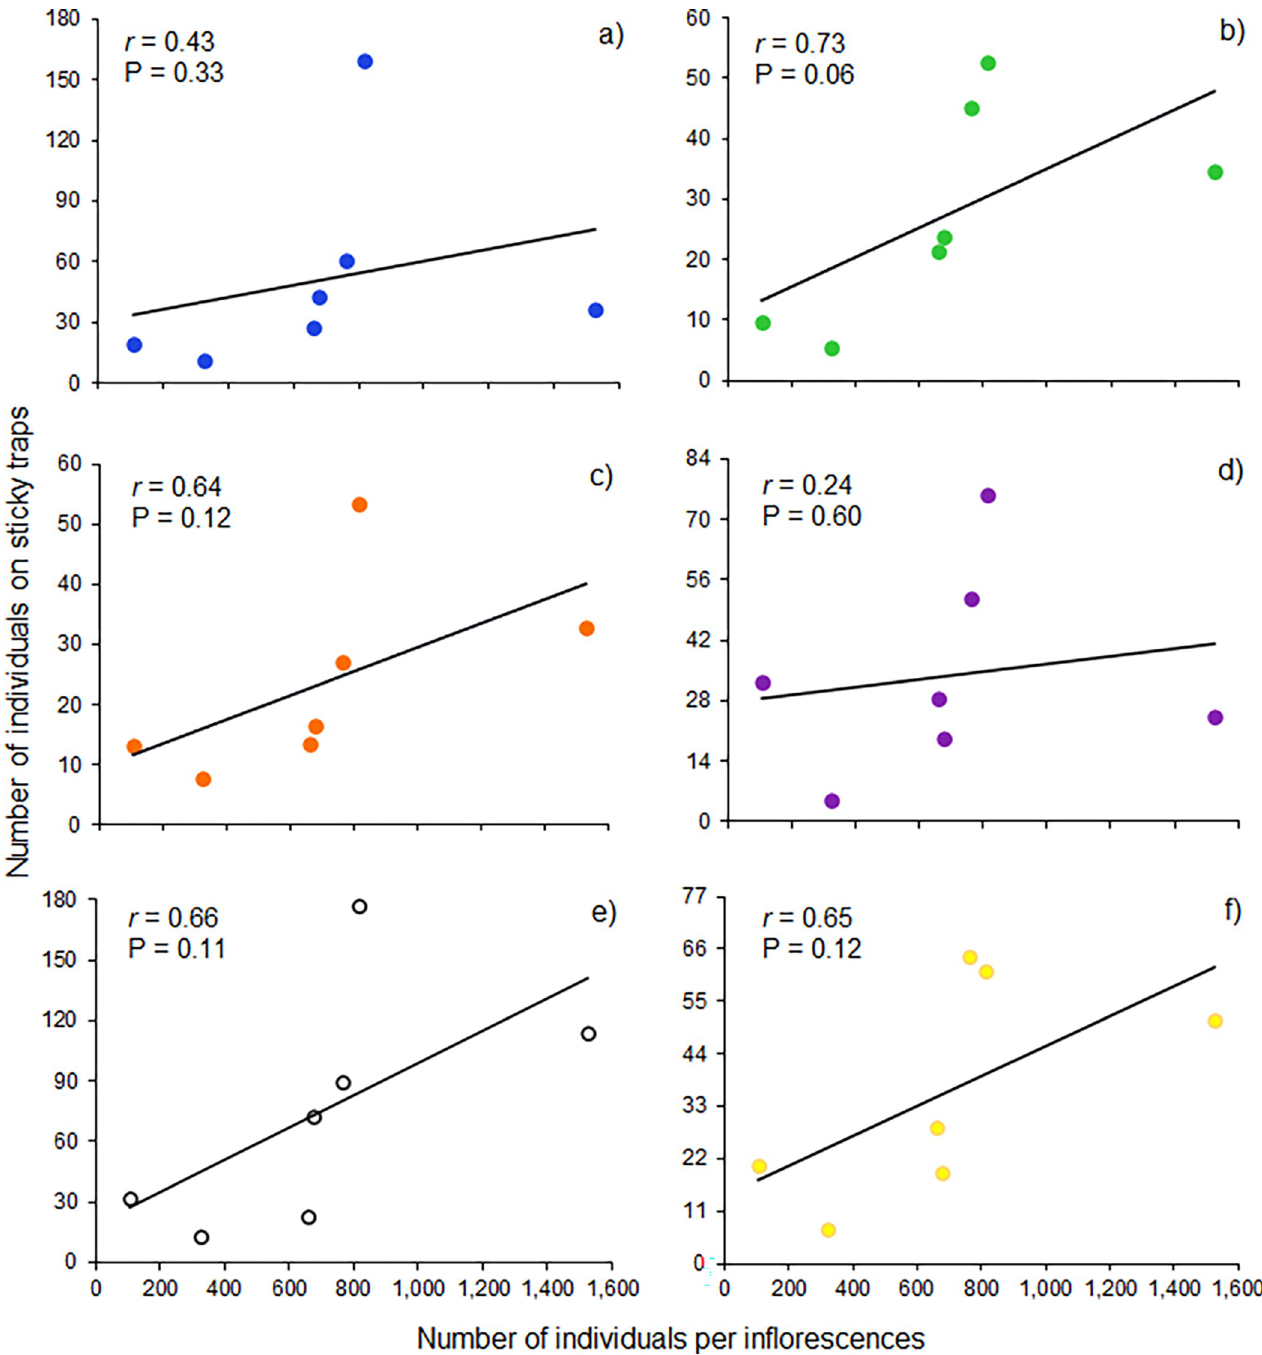
Fig 6. Thrips caught on traps versus inflorescences. Relationship between the average number of Frankliniella species captured on colored sticky traps (mean catches for each sampling date) and the average number of Frankliniella in the inflorescences (mean catches in 20 inflorescences): a) blue, b) green, c) orange, d) purple, e) white and f)